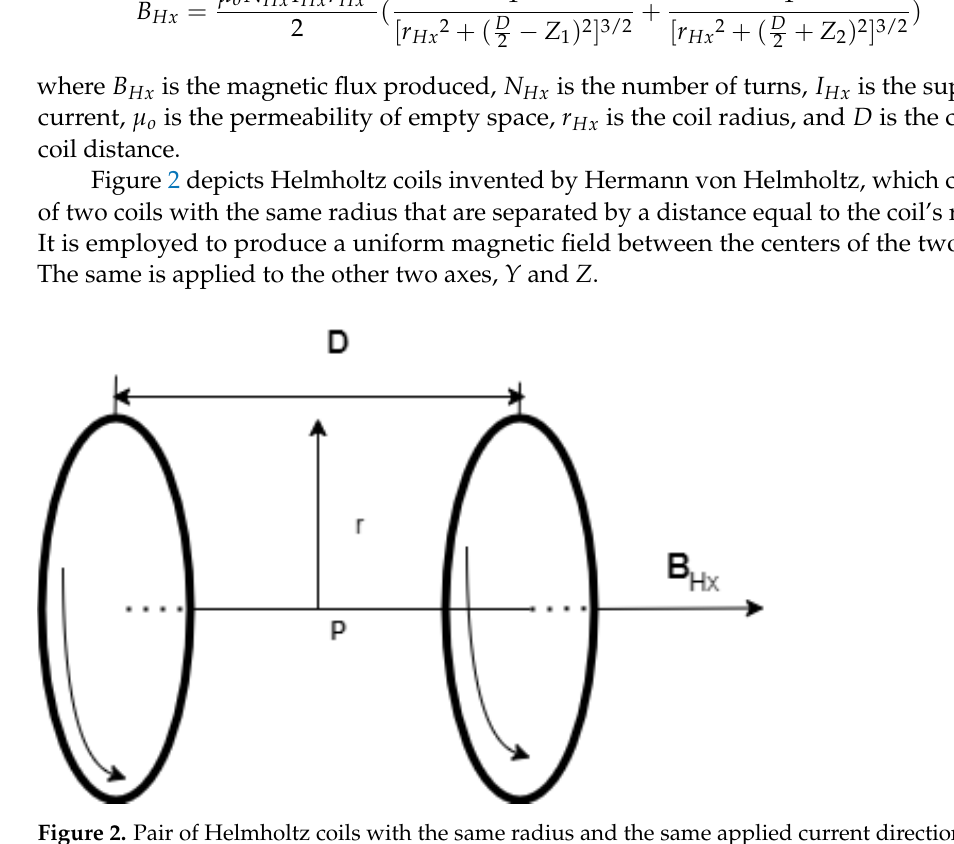
Figure 2. Pair of Helmholtz coils with the same radius and the same applied current